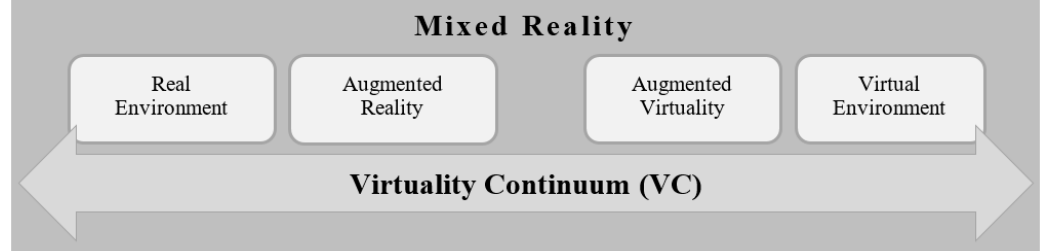
Figure 1: Reality-virtuality continuum by Milgram and Kishino